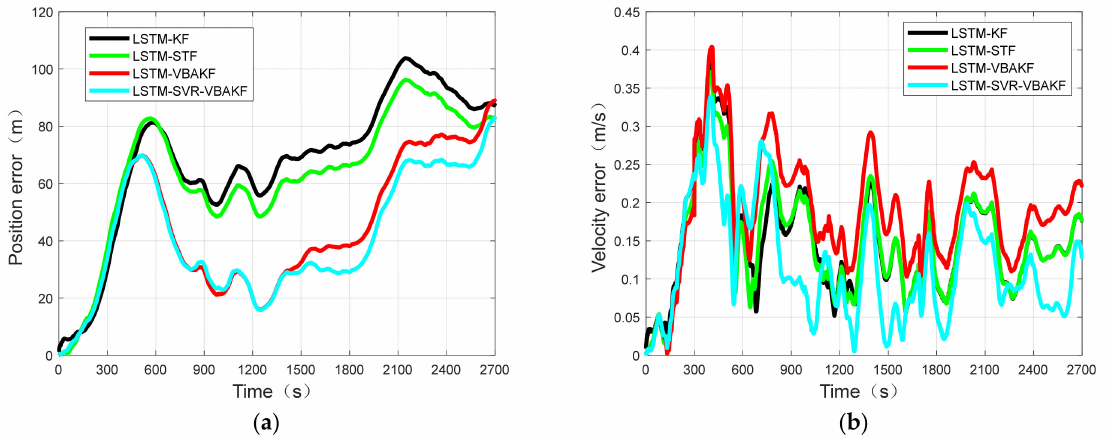
Figure 16. Comparison of navigation position and velocity error results: ( a ) Comparison of position errors; ( b ) Comparison of velocity